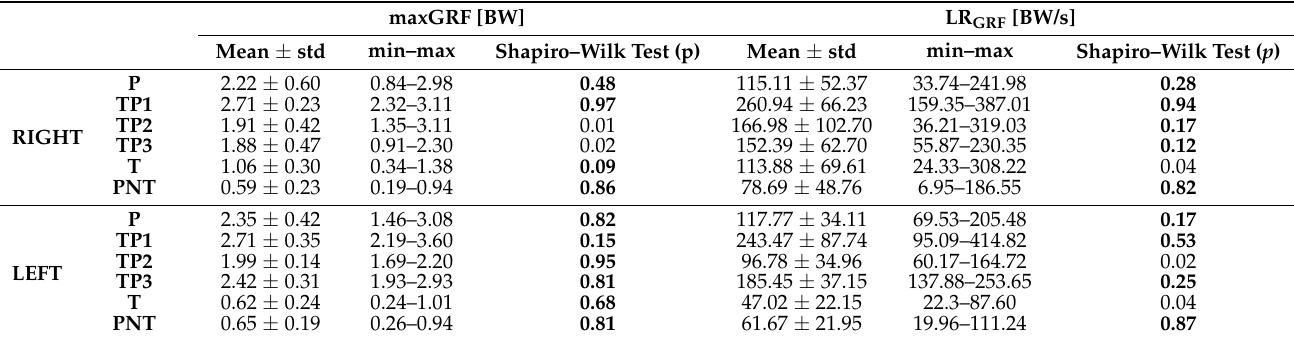
The p -value for normal distribution is in bold; maxGRF—maximal value of the vertical component of ground reaction force; LR GR —value of loading rate of GRF force; BW—body weight; std—standard deviation. Footwork steps during ZAP-3: P—Planta; TP1, TP2, TP3—Tac ó n de Planta; T—Tac ó n;